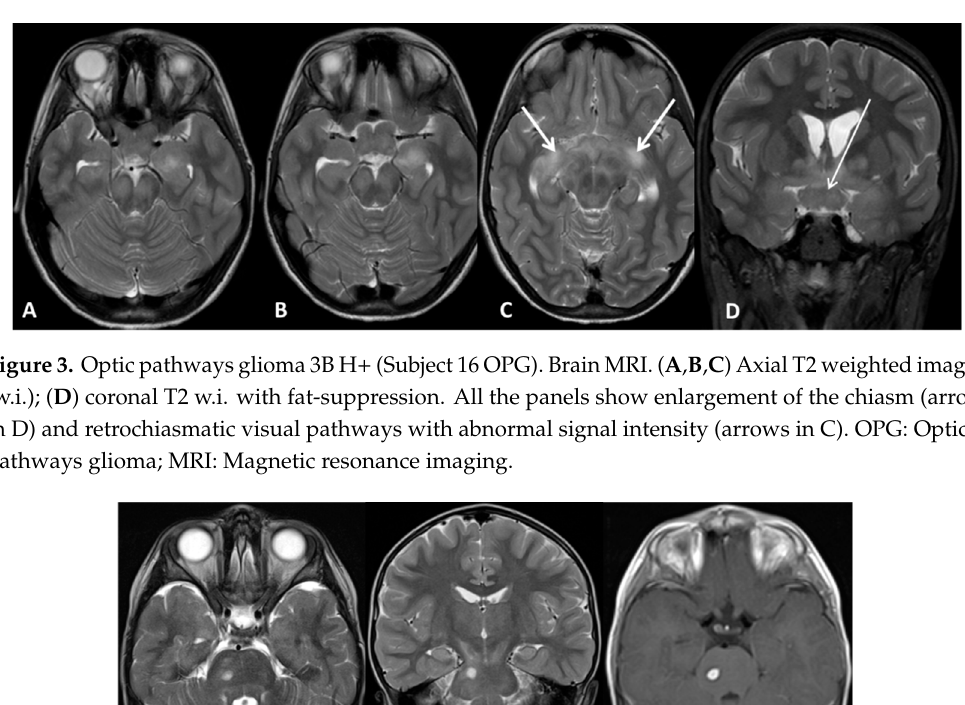
10 of 20 Figure 2. Chiasm and hypothalamic glioma 2aH+ (Subject 09 OPG). Brain MRI. ( A ) Axial T2 weighted